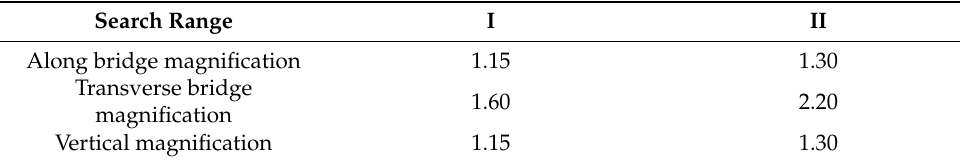
Figure 5. Comparison of two algorithms. Table 4. Two working